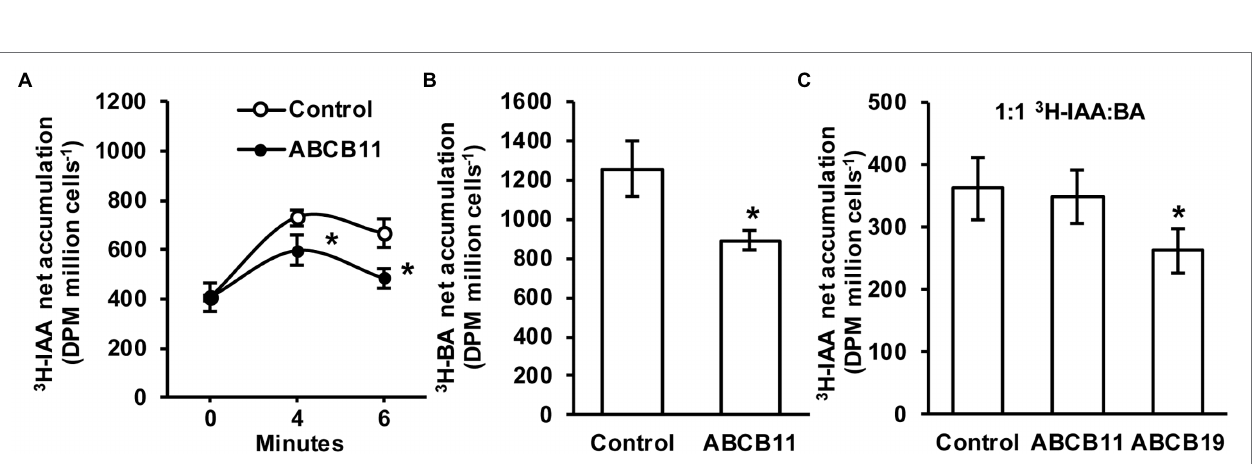
FIGURE 8 | Transport activity of ABCB11 expressed in Schizosaccharomyces pombe . (A) 3 H-IAA accumulation in S. pombe expressing ABCB11 or empty vector control plasmid. Data shown are means ± SD ( n = 4 independent transformations). (B) 3 H-benzoic acid (BA) accumulation in S. pombe expressing ABCB11 or empty vector control plasmid. Data shown are means ± SD ( n = 4 independent transformations). (C) Competition of 3 H-IAA with cold benzoic acid (BA; 1:1 molar ratio) in S. pombe expressing ABCB11, ABCB19, or empty vector control plasmid. Data shown are means ± SD ( n = 4 independent transformations). Asterisks indicate statistical difference by Student’s t -test (* p <